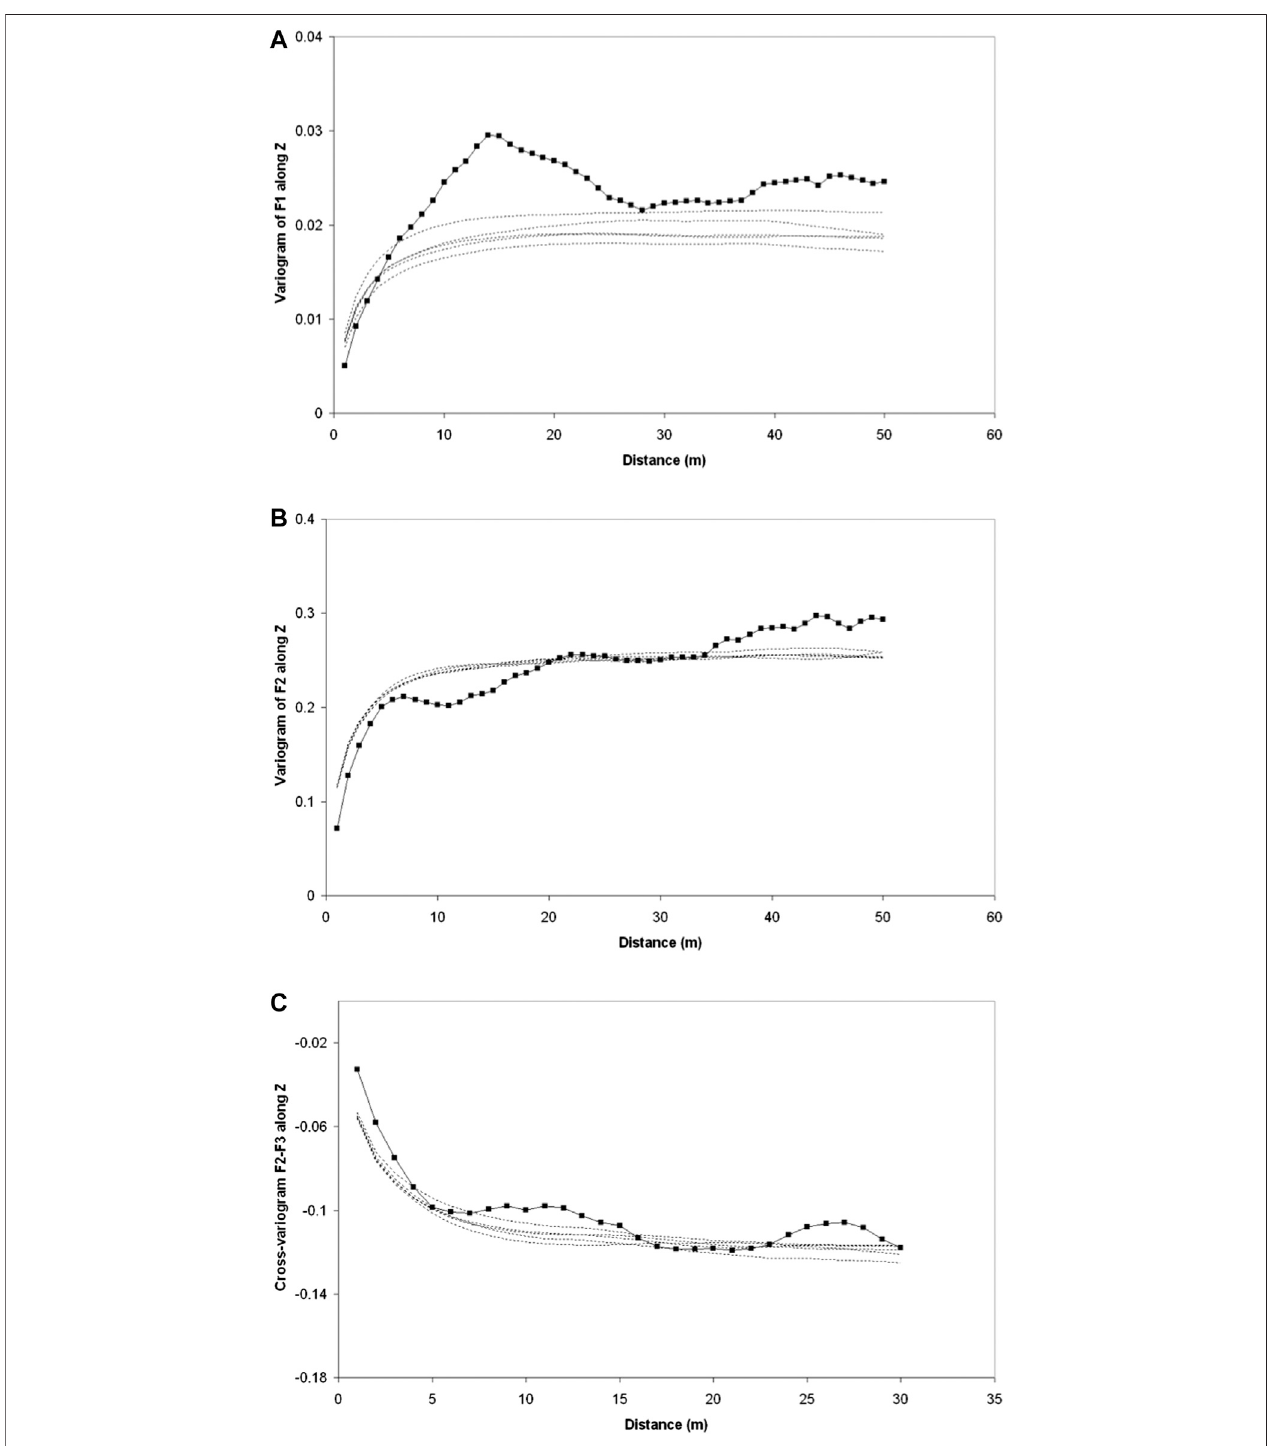
FIGURE11| Variograms of theborehole data (solid line) and the simulations(dashed lines) calculated for theverticaldirection. (A) Variogram of hydrofacies F1. (B) Variogram of hydrofacies F2 and (C) Cross-variogram of hydrofacies F2 and F3.